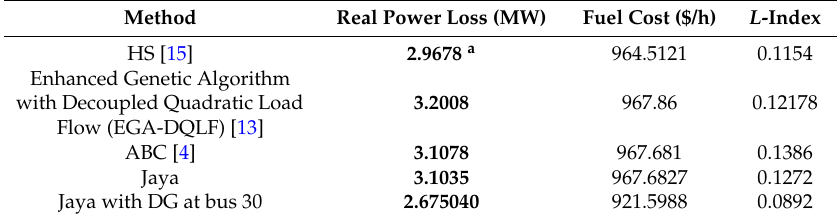
Table 3. Comparison of the results obtained for real power losses (modified IEEE 30-bus